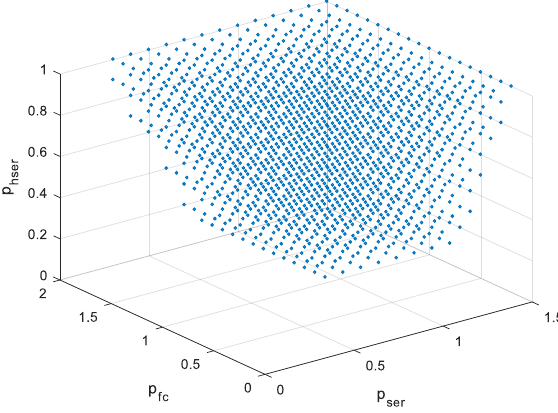
Figure A1. The tripartite game Nash equilibria diagram for r ≤ Q